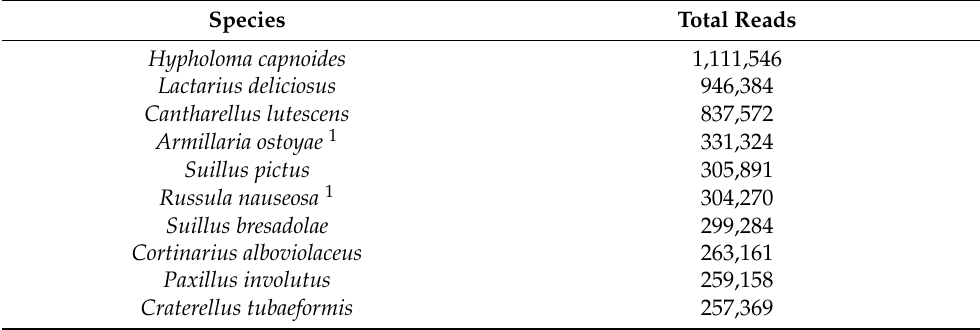
Figure 1. Cumulative number of macroscopic mushroom species (with >500 reads total) found in white-tailed deer feces on Anticosti Island (Quebec, Canada) according to the number of fecal samples in 2014 (light gray) and 2015 (dark gray). Table 2. List of the 10 macroscopic mushroom species with the highest total number of reads in the 238 subsamples of white-tailed deer feces collected on Anticosti Island (Quebec, Canada) in 2014 and 2015.